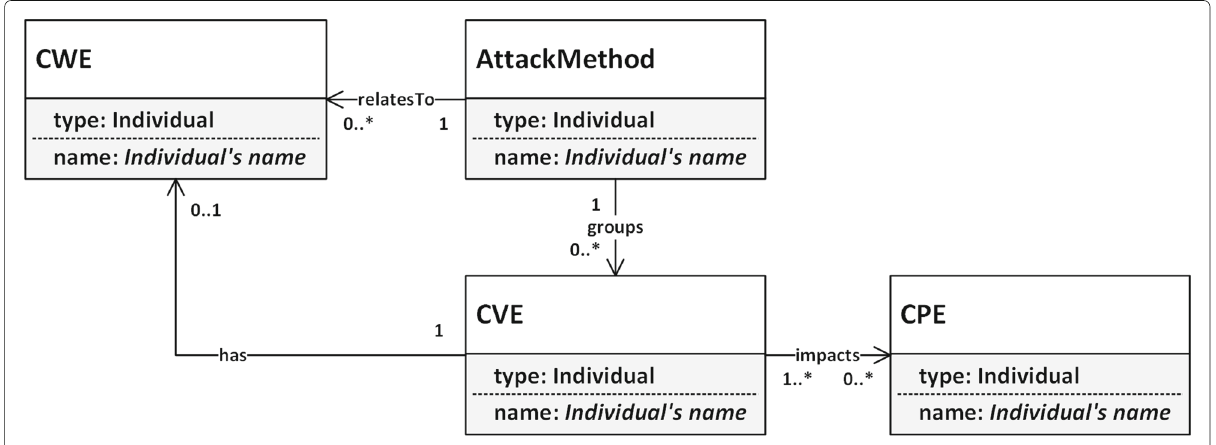
Fig. 6 Classification of